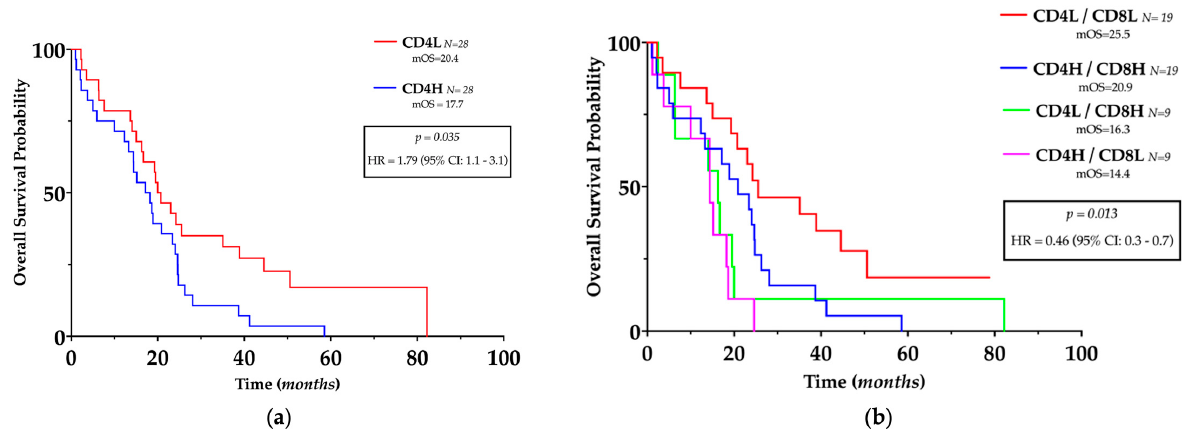
Figure 4. Prognostic impact of TILs in glioblastoma. ( a ) Kaplan–Meier plots of overall survival, stratified by the predefined cut-off points for CD4+ cells. ( b ) Kaplan–Meier plots of overall survival, stratified according to the different TILs pattern stratified by the predefined cutoff points for CD4+ and CD8+ cells. L: low; H: